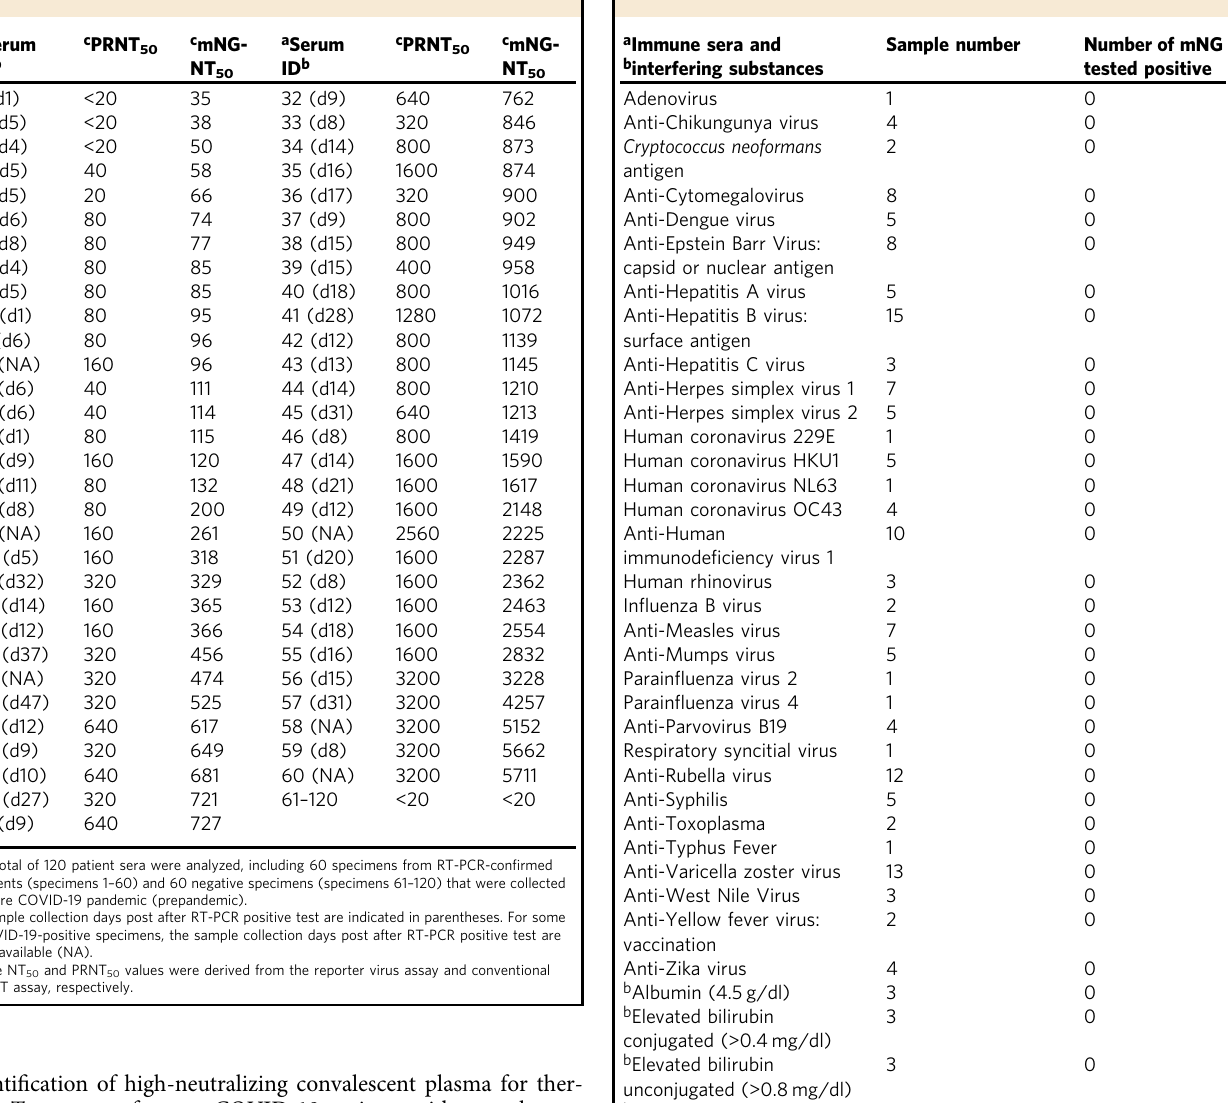
Table 1 Comparison of neutralization titers of patient sera analyzed by reporter assay and plaque reduction assay.